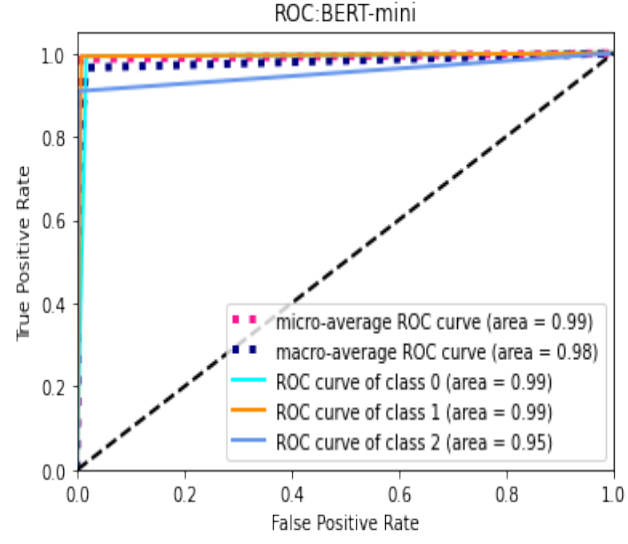
Figure 6. ROC curve using ABMM